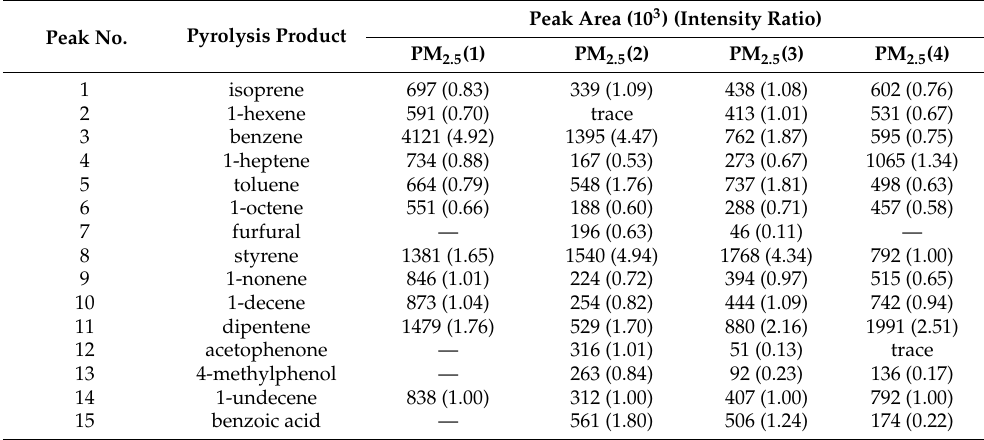
Table 2. Peak areas and relative intensity ratios (the reference: 1-undecene) of the major pyrolysis products detected in the PM 2.5